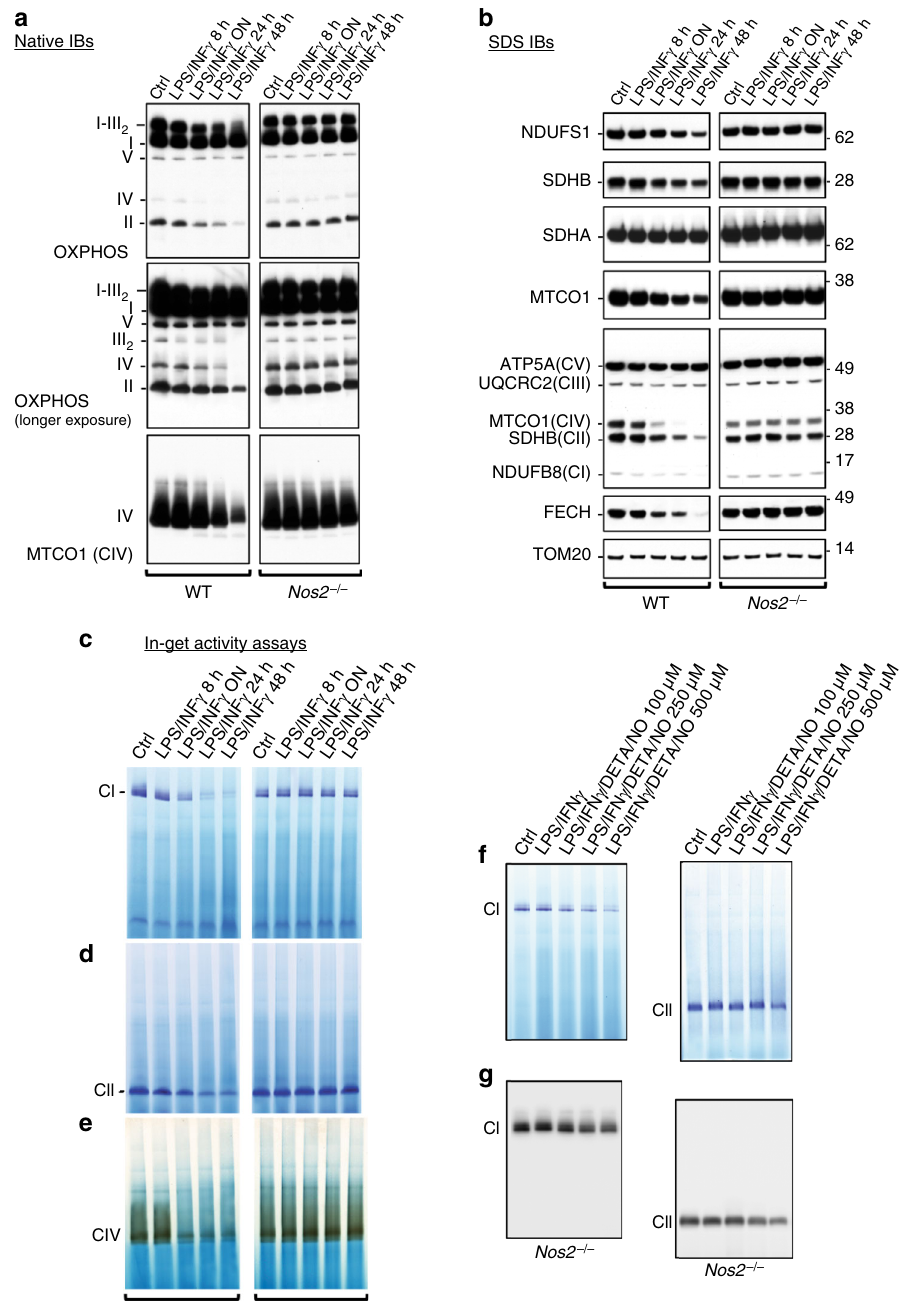
Fig. 6 NO inhibits mitochondrial ETC complexes and promotes their loss. a Native IBs were performed to assess assembly of complexes I – V (CI – V) in BMDMs after activation with LPS + IFN γ for indicated times. Total OXPHOS IB was performed to detect the CI subunit NDUFB8, the CII subunit SDHB, the CIII-Core protein 2 (UQCRC2), the CIV subunit I (MTCO1, also detected by IB with speci fi c antibody) and the CV alpha subunit (ATP5A). b SDS IBs including the CI subunit NDUFS1, the CII subunit SDHA, and the Fe-S protein ferrochelatase (FECH). Levels of TOM20 were used as mitochondrial matrix marker for loading controls. IBs were performed on samples described in a . ( a – d , n = 4 biological replicates). c CI, d CII, and e CIV in-gel activity assays were performed in activated WT and Nos2 − / − cells at reported time points. f CI and CII in-gel activities in Nos2 − / − BMDMs stimulated with LPS + IFN γ in the presence of increasing concentration of DETA/NO (100, 250 and 500 μ M) ( g ) SDS IBs for CI (NDUFS1) and CII (SDHA) performed on samples described in f